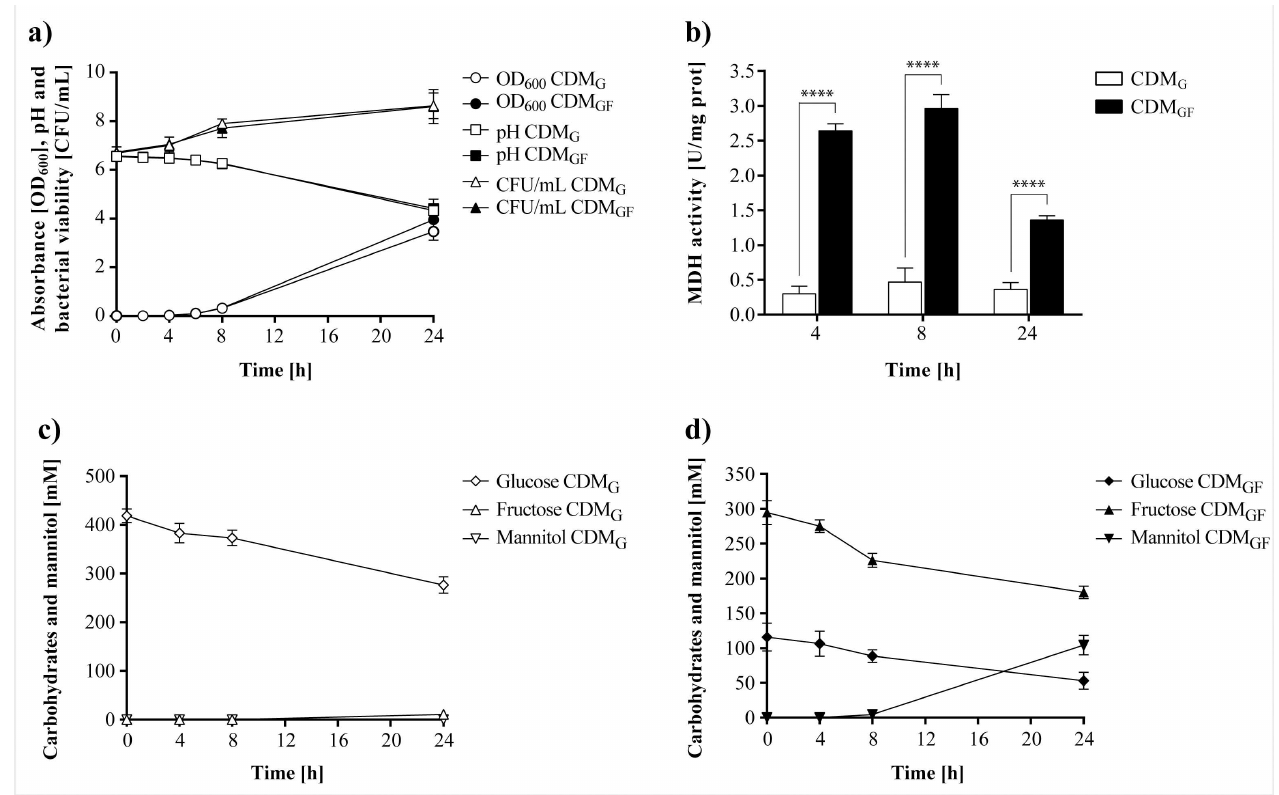
Fig 3. Cell growth and MDH activity of L . reuteri CRL 1101 grown in CDM G and CDM GF at 37˚C for 24 h. a) Growth kinetics in both media; b) Specific MDH activity in both media; c, d) Carbohydrate consumptionand mannitolproduction in CDM G and CDM GF , respectively.Statistical analysisin Fig 3b was performed using two-way ANOVA followedby Bonferroni post-test. A value of p < 0.05was considered statistically significant. ns p > 0.05, * p < 0.05, ** p < 0.01, *** p < 0.001, **** p < 0.0001.